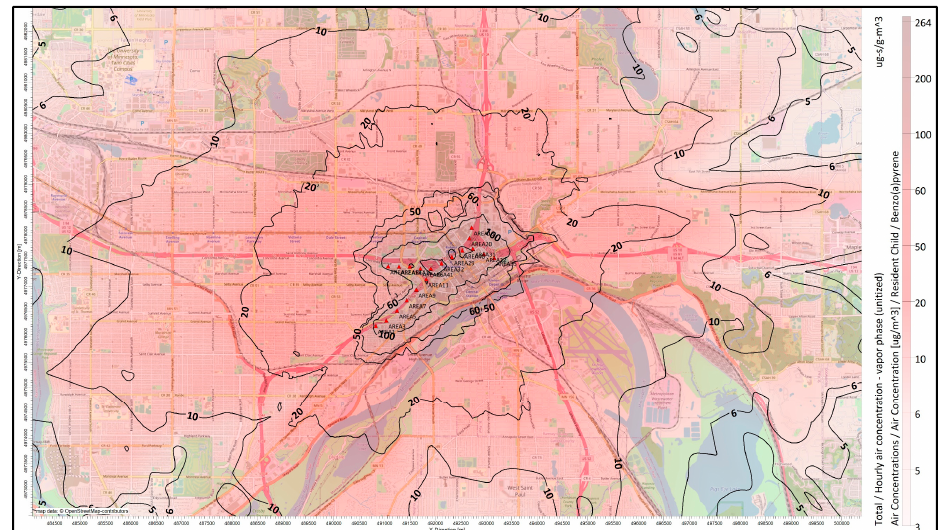
Figure 9. BaP Hourly Air Concentration—Vapor Phase (Unitized) Contour Plot overlaid on Open- StreetMap Satellite Imagery (OpenStreetMap, n.d.). Unit used in contour is µg-s/g-m 3 .